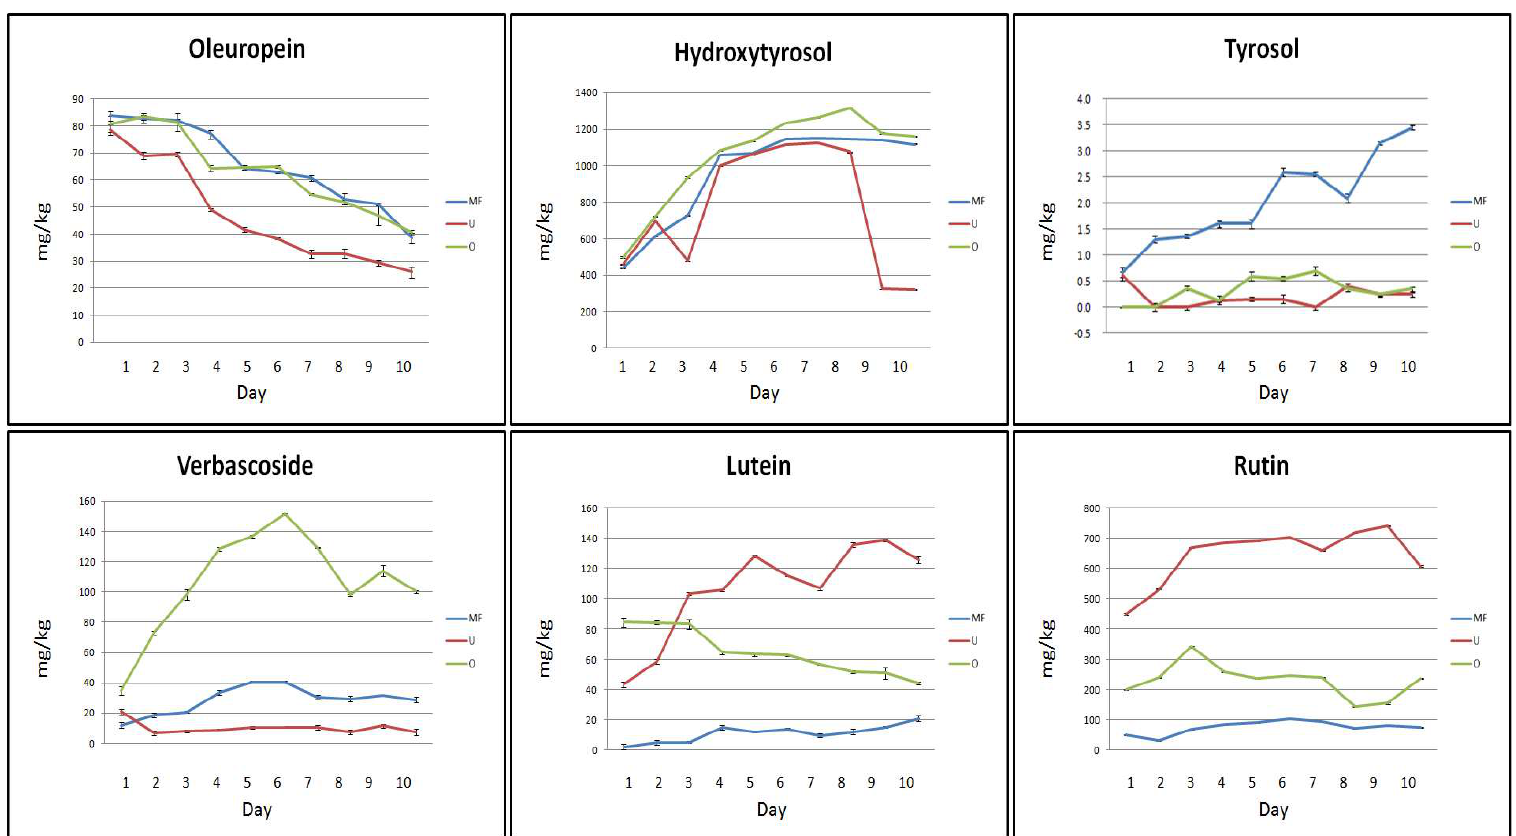
Figure 2. Trend of the concentrations of bio-active compounds in aqueous extracts of whole olive leaves. Three types of water were tested: ultrapure(U), microfiltered (MF), and osmosis-treated (O) water. Data are expressed as the means ± SEM of three independent observations. Statistical results from one-way analysis of variance (ANOVA) followed by Tukey-test are provided in Table S1 in Supporting Information.